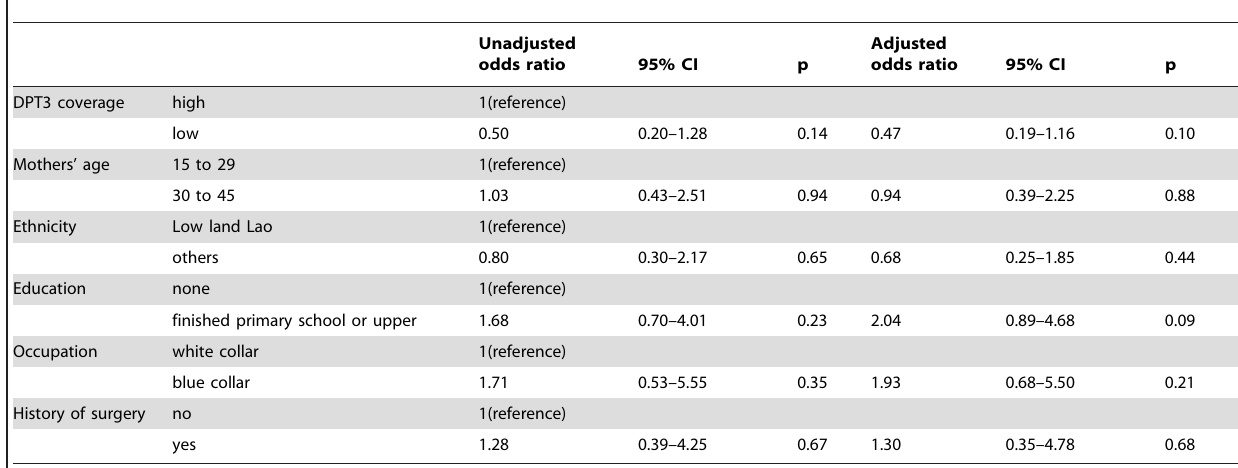
Table 4. Unadjusted and adjusted odds ratio for being HBsAg positive among mothers from 15 to 45 years old in Lao PDR by selected background characteristics.